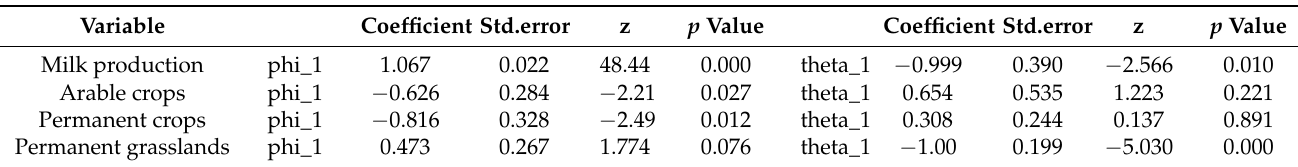
Table 4. ARIMA model of milk organic production and organic land in the EU in the years 2005–2018. Variable Coefficient Std.error z p Value Coefficient Std.error z p Value Milk